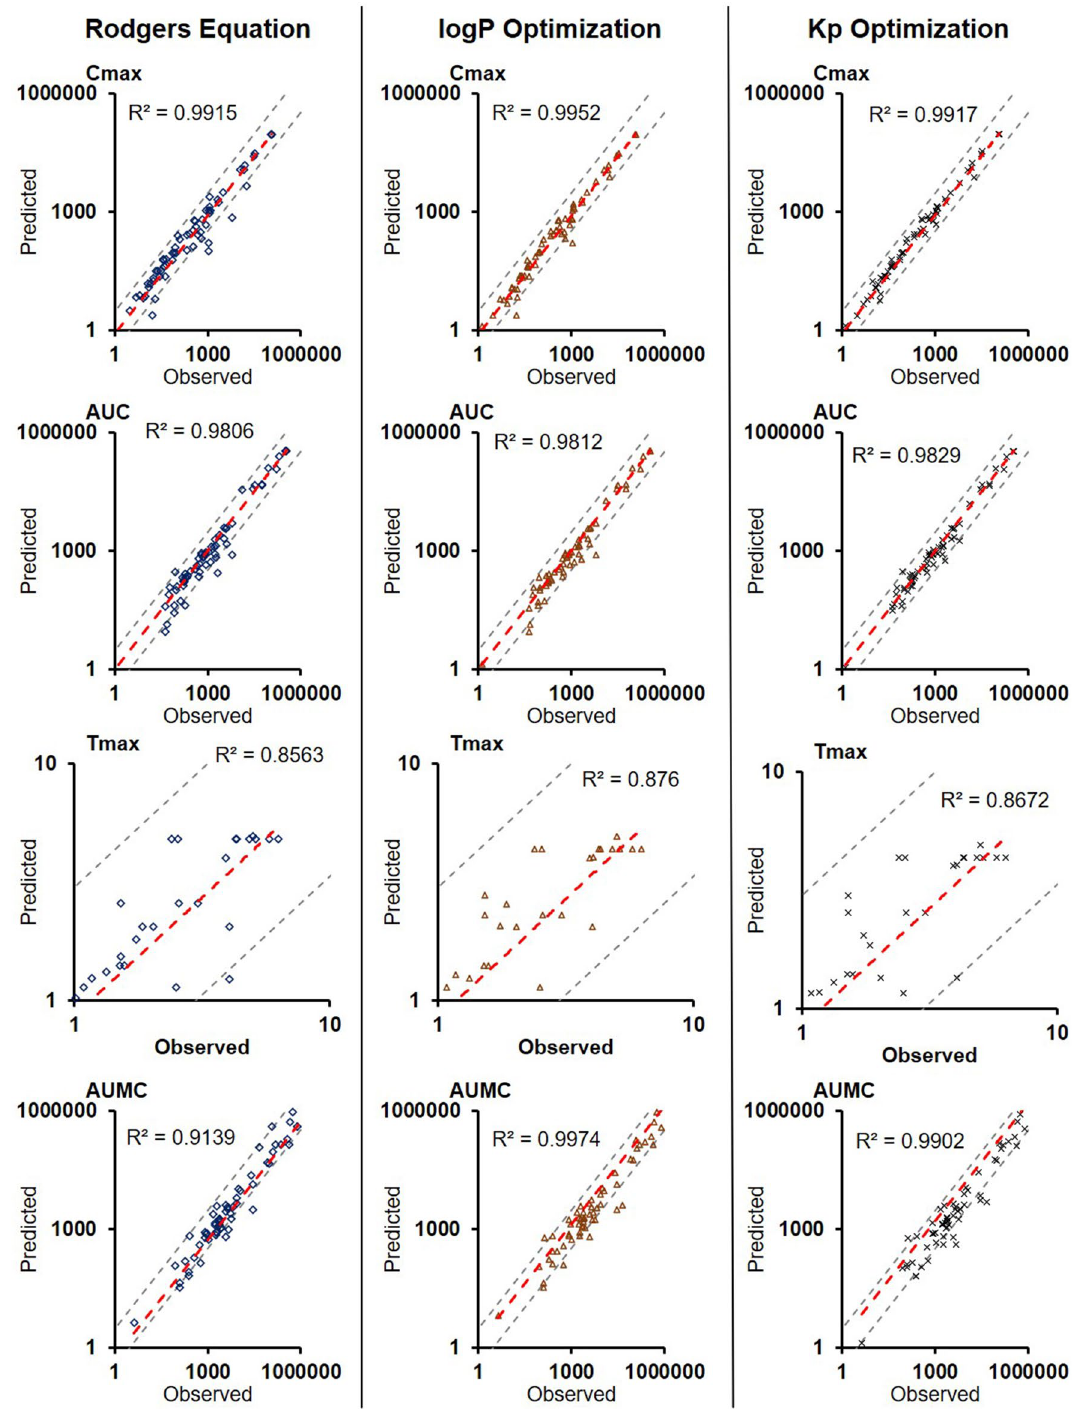
Figure 3. Plots of Observed vs. Predicted PK metrics across the different optimization conditions for firstt- order PK outputs. Red lines correspond to lines of best fit, gray lines are bounds of ±